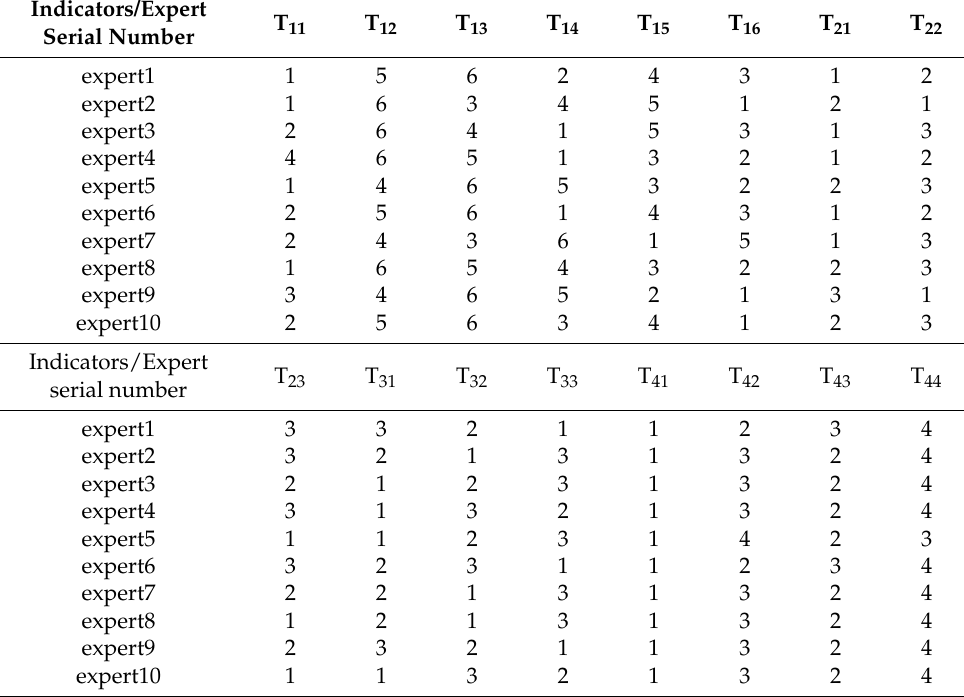
Table 10. The Importance ranking table of secondary indicator